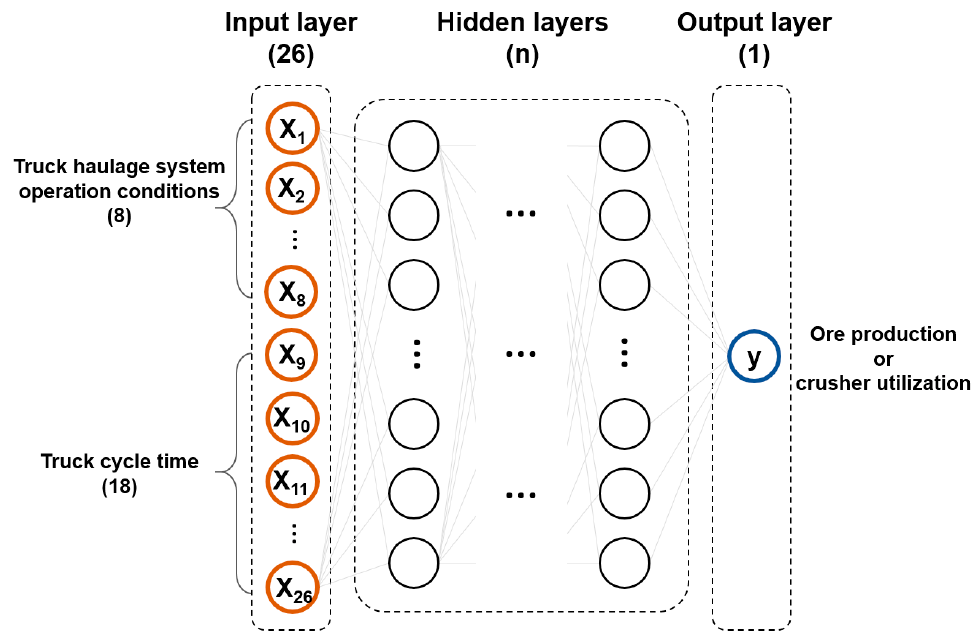
Figure 3. Design of DNN model for predicting ore production and crusher utilization.